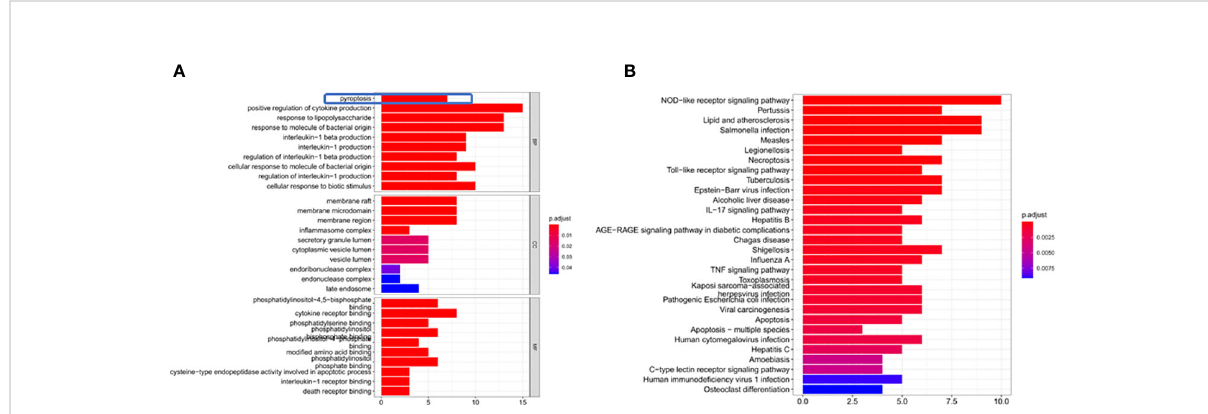
FIGURE 3 DEG enrichment analysis. (A) The results of the GO enrichment in TCGA cohort. “ BP ” stands for “ biological process ” , “ CC ” stands for “ cellular component ” and “ MF ” stands for “ molecular function ” . The abscissa represents the gene ratio. (B) The results of the KEGG enrichment in TCGA cohort. The abscissa represents the gene ratio.